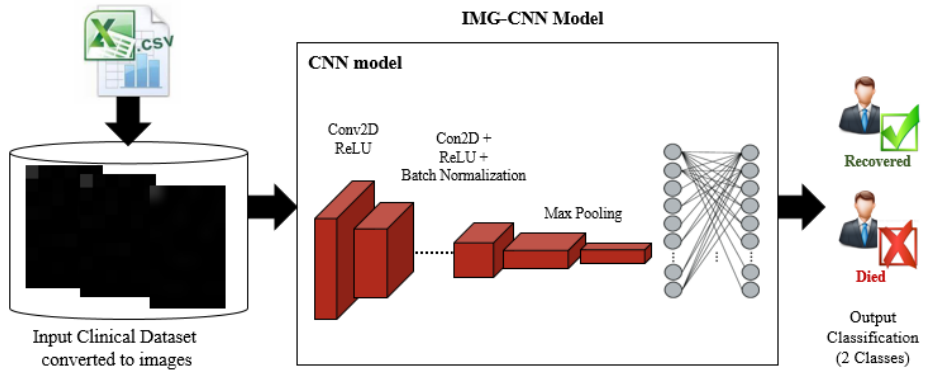
Figure 9. A schematic diagram of the proposed IMG-CNN